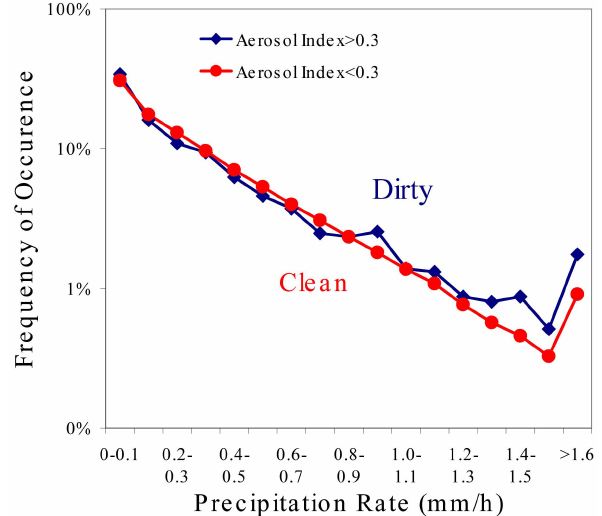
Fig. 3. Frequency of occurrence of different precipitation rates un- der relatively clean and polluted atmospheric